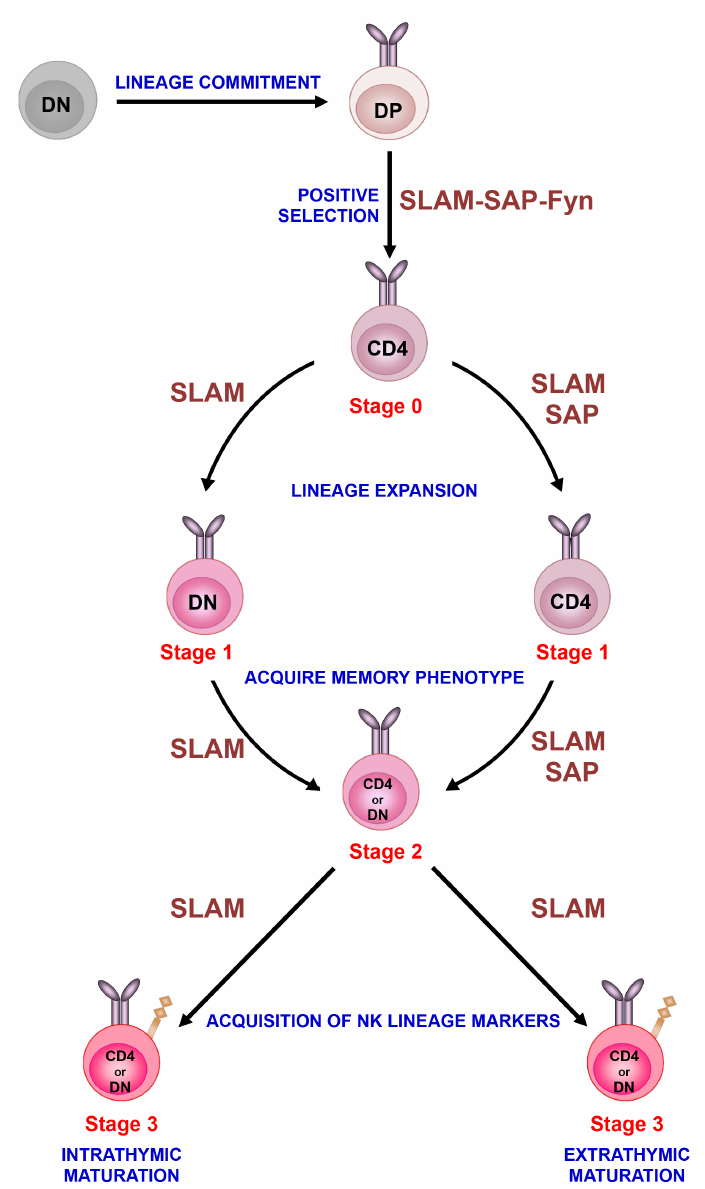
Figure 1. Sequential lineage development model. Invariant NKT cells develop in the thymus following homotypic interactions between CD4 + CD8 + DP thymocytes that express the invariant TCR. After positive selection, immature iNKT cells progress through distinct stages of maturation that are characterized by di ff erences in the surface expression of CD24, CD44 and NK1.1. Immature iNKT cells (stage 0) undergo lineage expansion (stage 1) and acquire a memory phenotype (stage 2) as well as markers of the NK cell (NK1.1) lineage (stage 3). Although most immature iNKT cells emigrate from the thymus at stage 2 and acquire NK1.1 expression in the periphery, a subset of stage 2 cells acquires this marker in the thymus and remains as long-term residents. The development of iNKT cells is critically regulated by the signaling lymphocyte activation molecule (SLAM) family of receptors (referred to as SLAM), SAP and Fyn. Based on recent studies, we have placed these signaling molecules along the iNKT cell developmental program at the various stages where their activity appears to be critical for iNKT cell